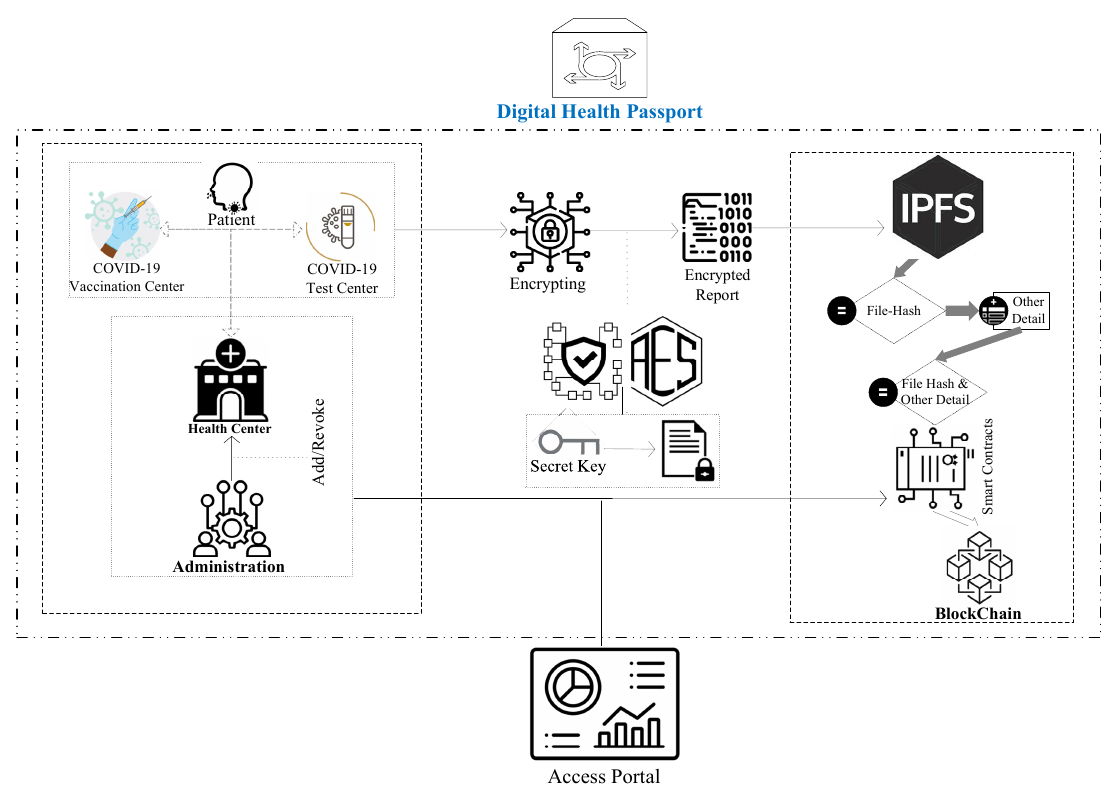
Figure 5. An overview of the detailed